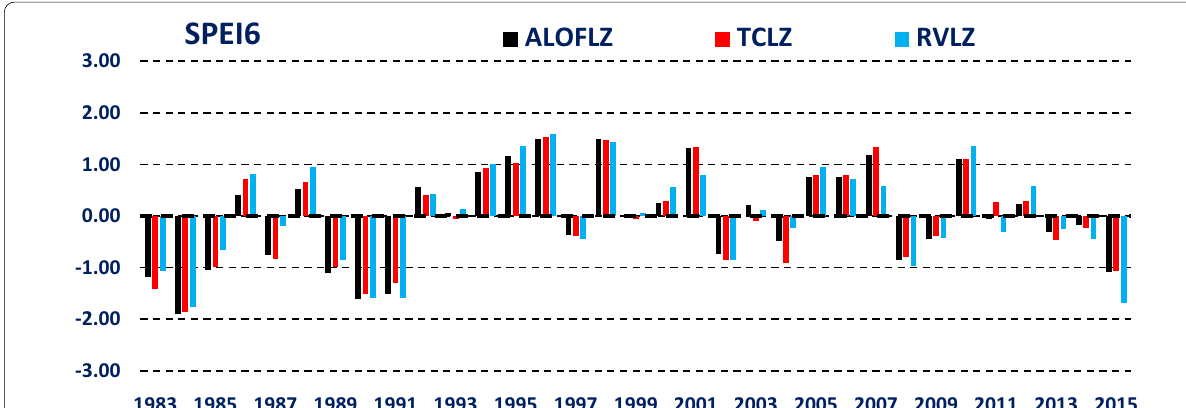
Fig. 8 Chart of temporal drought trends in combined rainy season’s from1983–2016